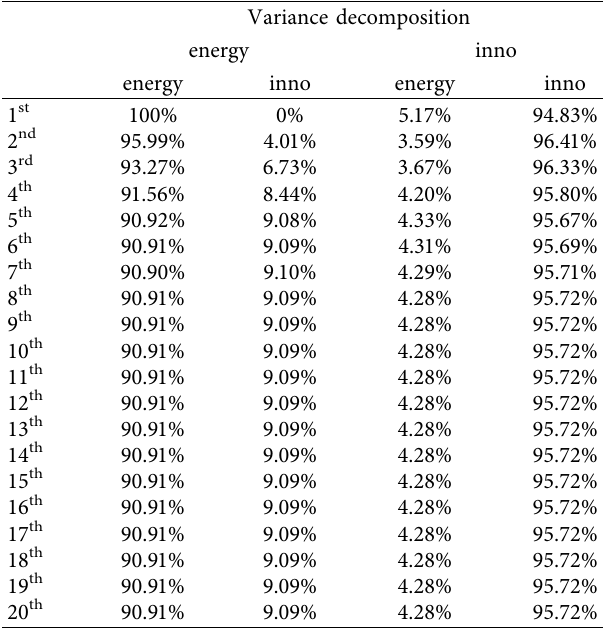
Table 5: Variance decomposition of the prediction error of core